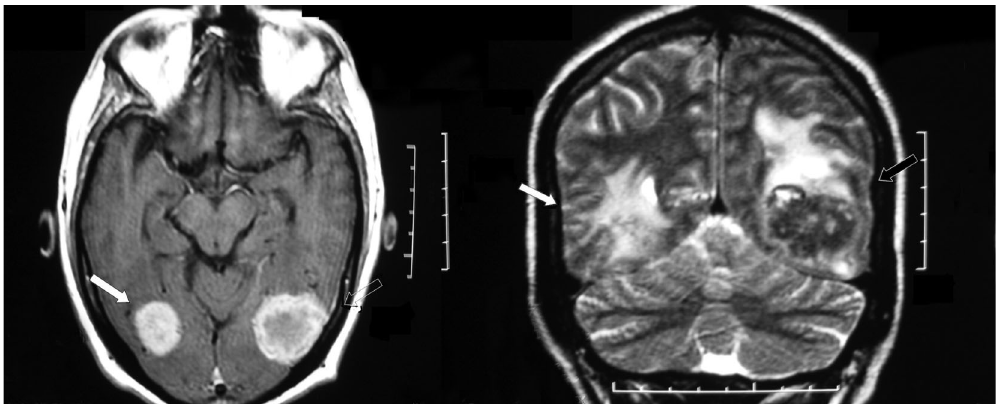
Figure 1. Preoperative MRI: arrows showing bilateral occipito-temporal metastasis with contrast enhance- ment.